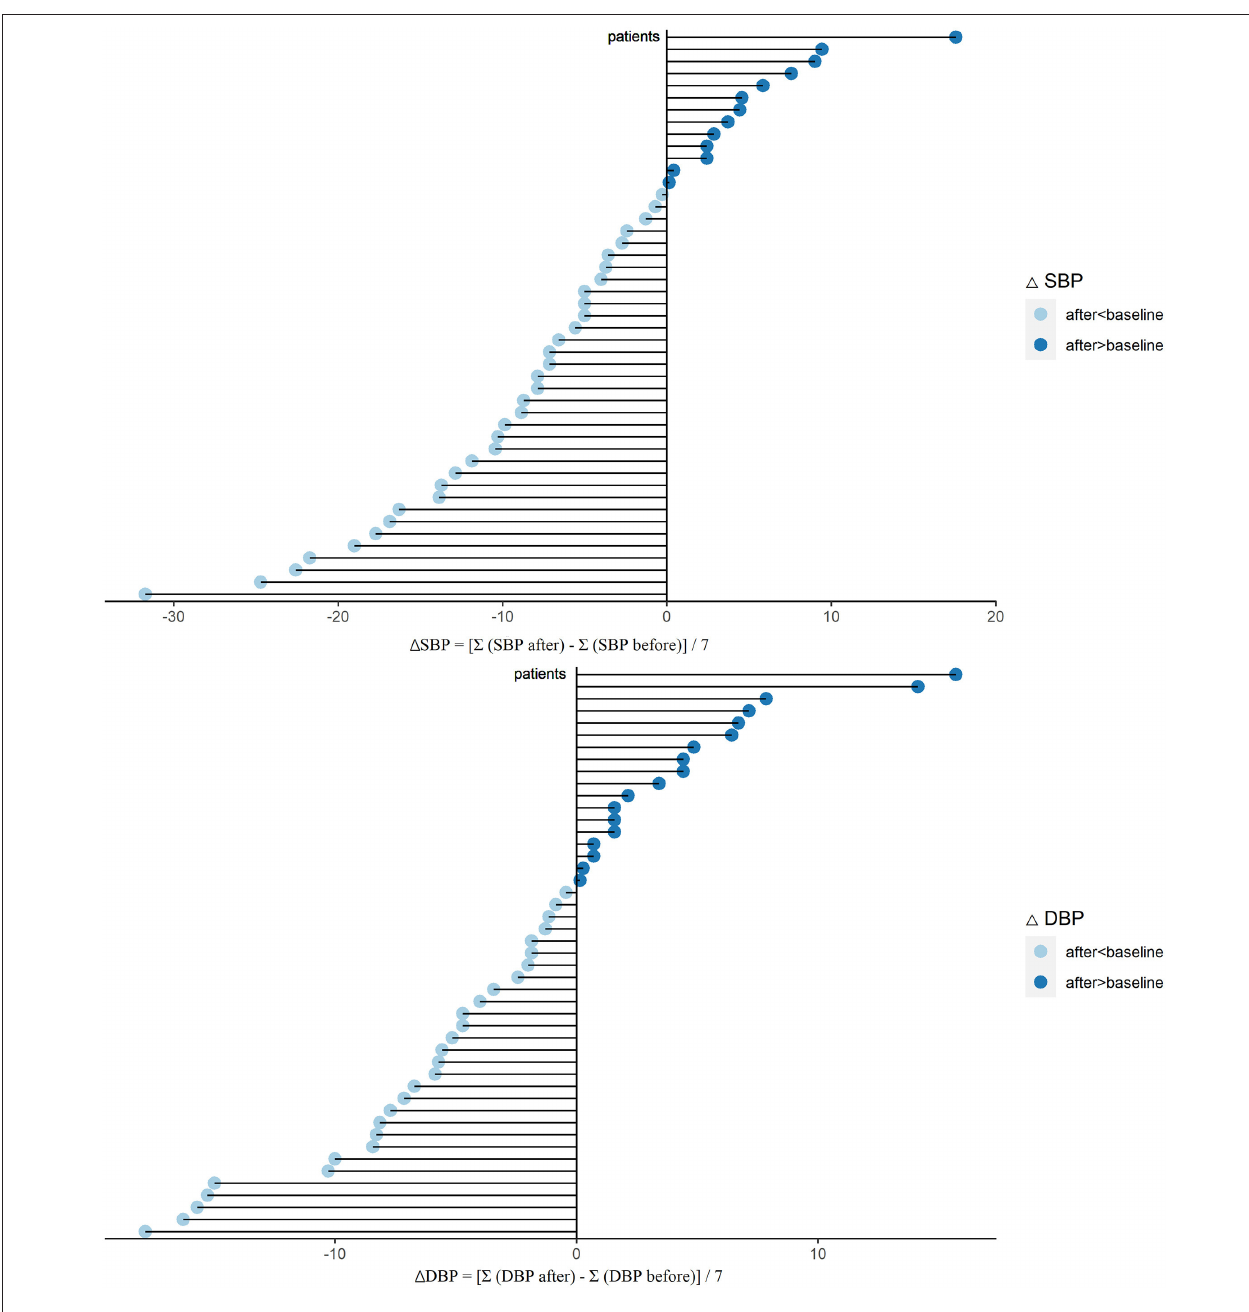
FIGURE 3 | Changes of SBP ( 1 SBP) and DBP ( 1 DBP) after sacubitril-valsartan initiating in PD patients. Daily BP level was collected during 7 days before (SBP or DBP before) and after (SBP or DBP after) sacubitril-valsartan treatment. 1 SBP = [ Σ (SBP after) – Σ (SBP before)]/7. 1 DBP = [ Σ (DBP after) – Σ (DBP before)]/7. After treated with sacubitril-valsartan, the BP levels of PD patients were markedly decreased (light blue color). SBP, systolic blood pressure; DBP, diastolic blood pressure; PD, peritoneal dialysis.